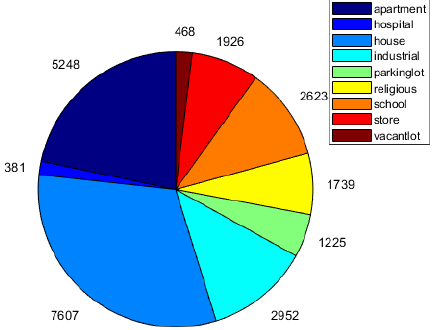
Figure 5. Class distribution of CV-BrCT